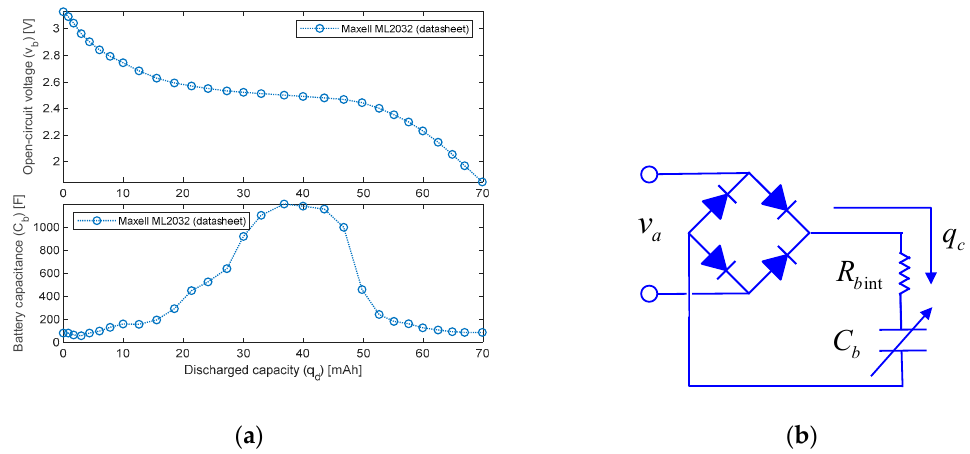
Figure 8. Energy harvesting simulation: ( a ) Maxell ML2032 Li-ion rechargeable battery characteristics [55]; ( b ) Thevenin battery model connected to the patches’ voltage output [56].